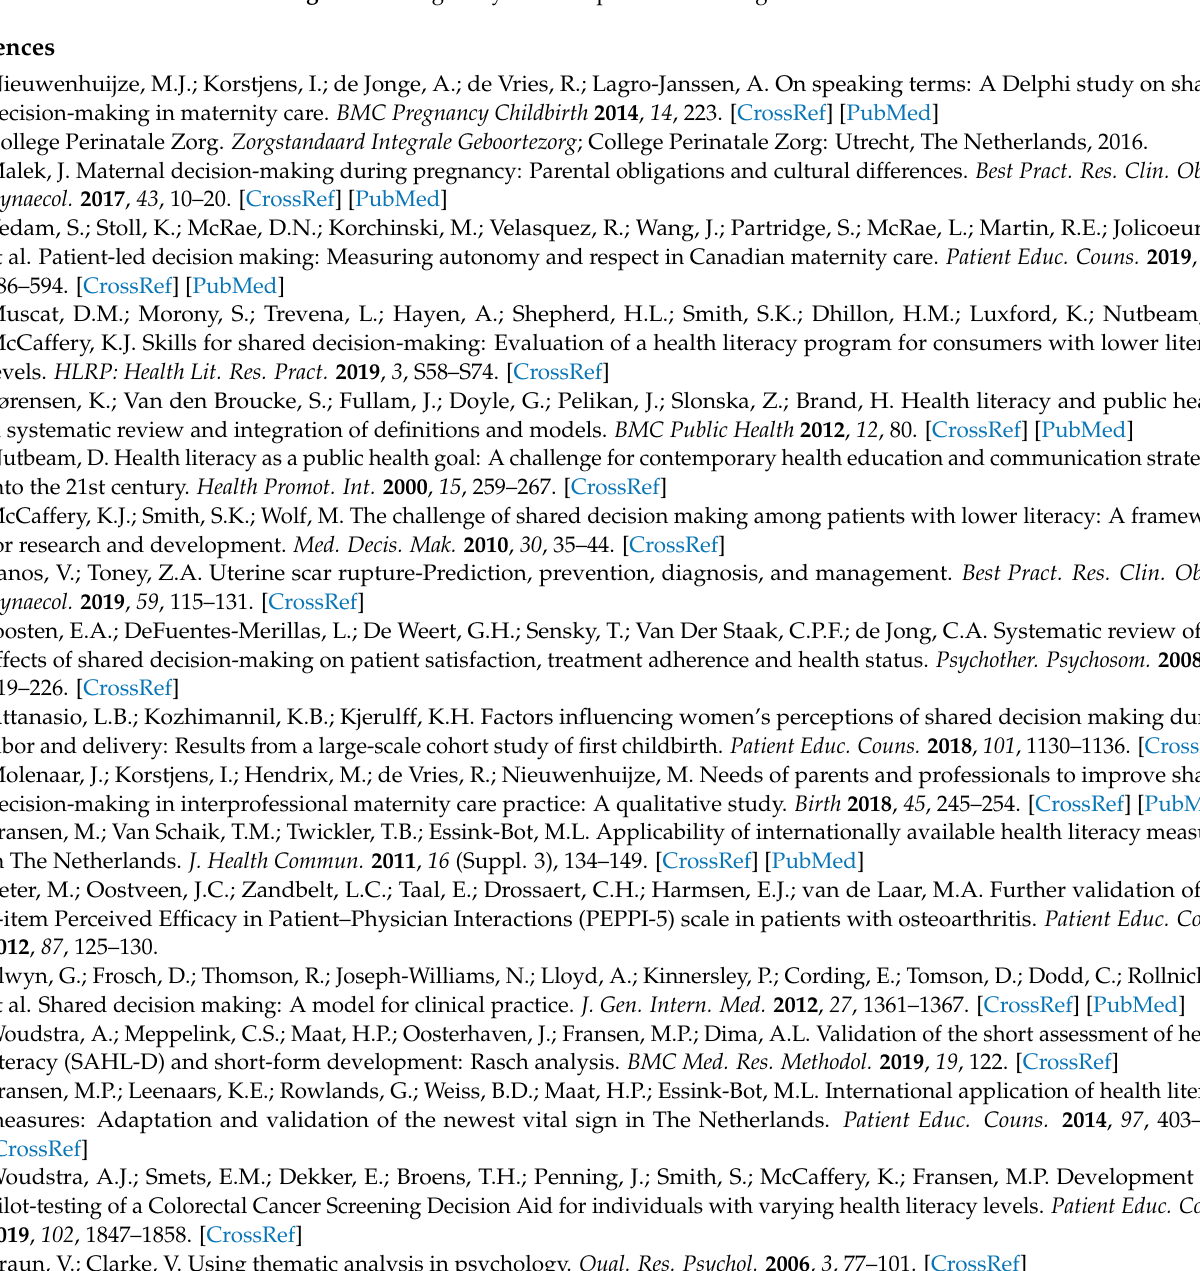
Figure A1. Pregnancy timeline presented during